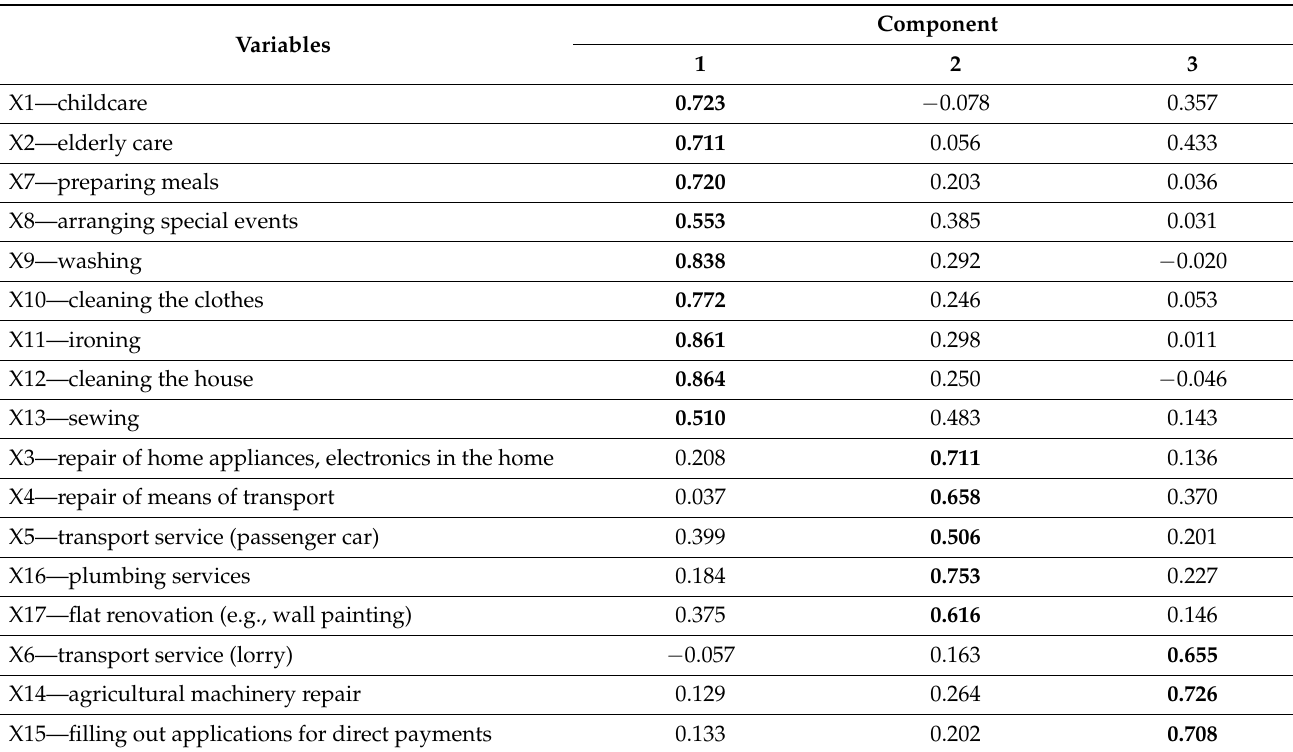
Table 6. Statistics for rotated component matrix. Rotation method—Varimax with Kaiser